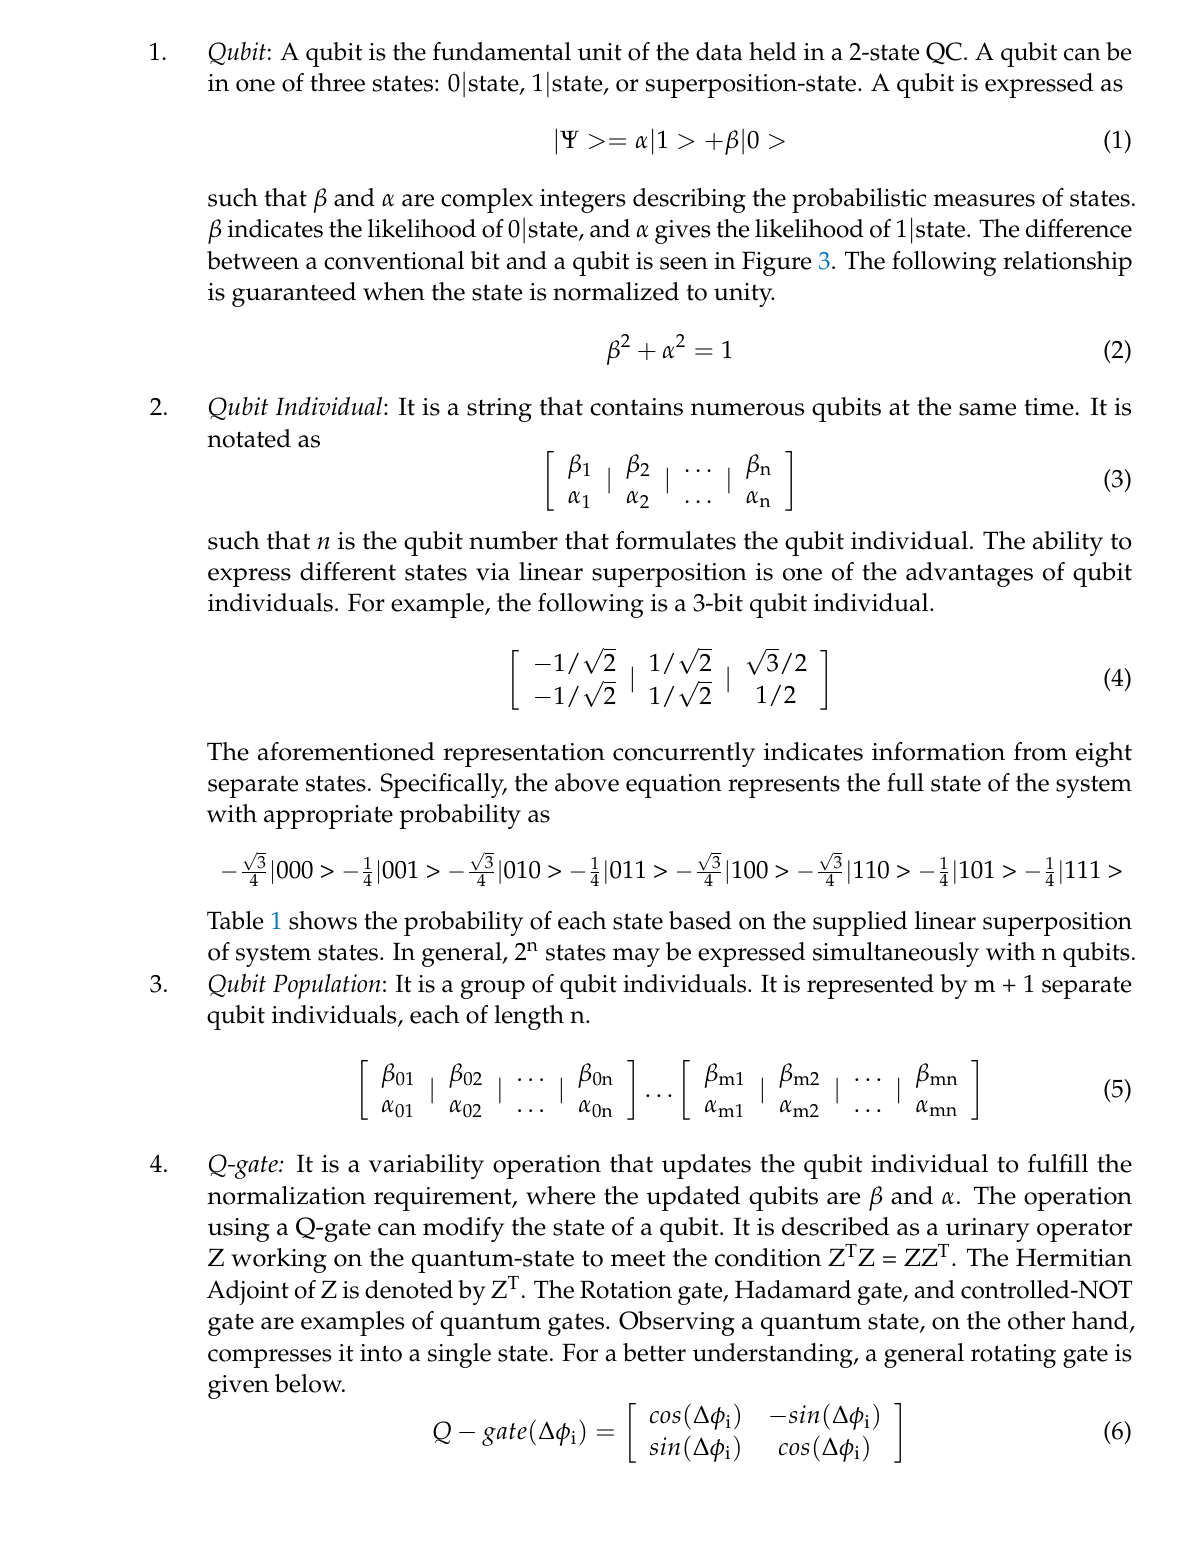
such that β and α are complex integers describing the probabilistic measures of states. β indicates the likelihood of 0 | state, and α gives the likelihood of 1 | state. The difference between a conventional bit and a qubit is seen in Figure 3. The following relationship is guaranteed when the state is normalized to unity.